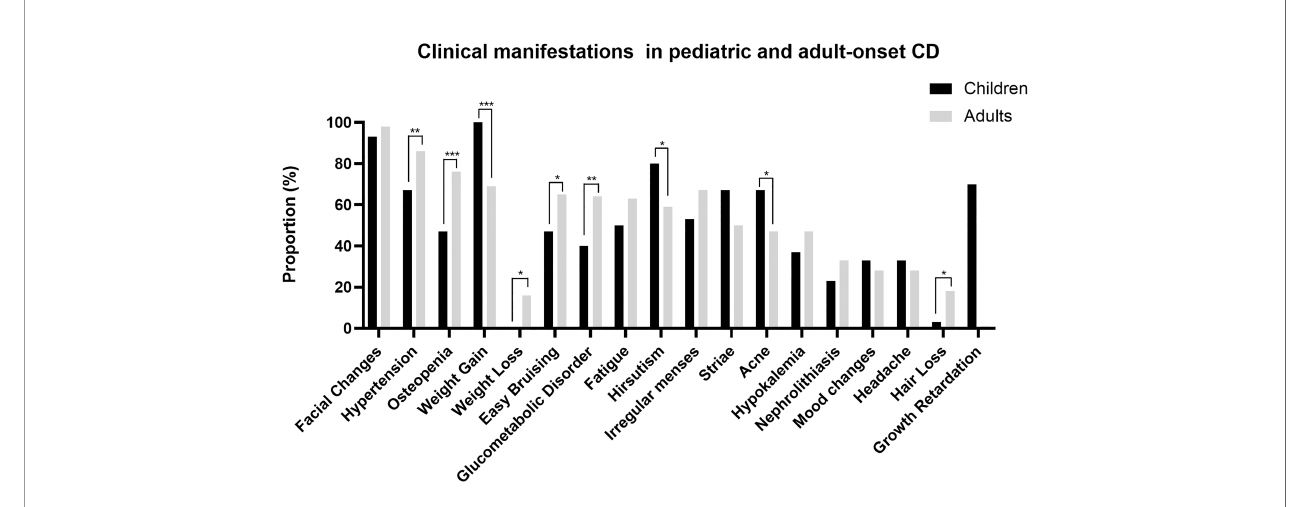
FIGURE 1 | Clinical manifestations in pediatric and adult-onset CD. * P < 0.05, ** P < 0.01, *** P <